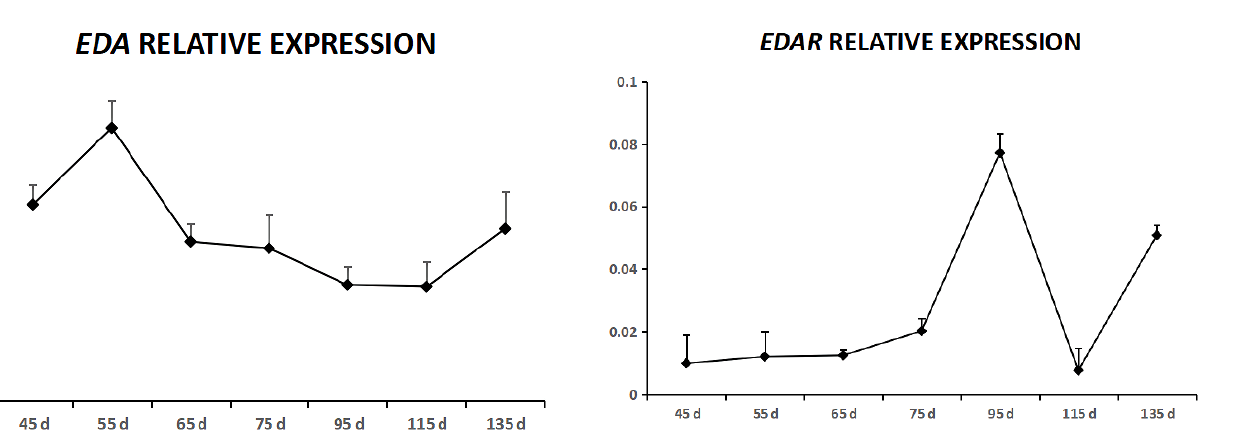
Figure 1. Relative expression levels of the EDA gene during the fetal period.